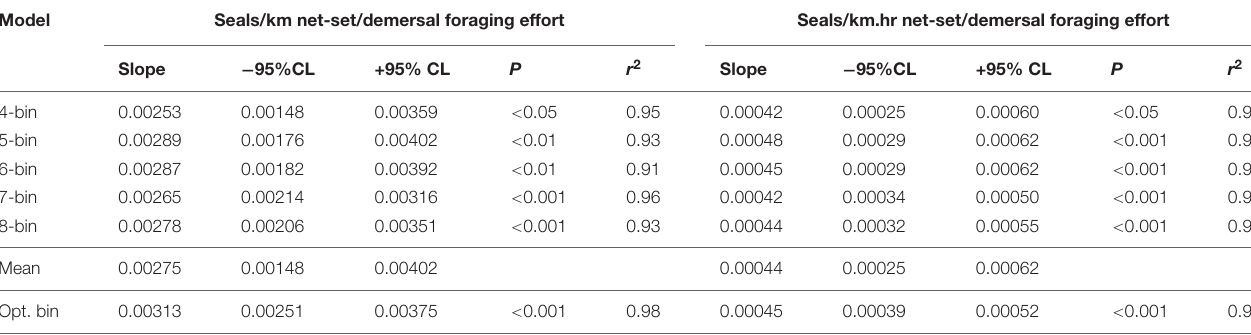
TABLE 3 | Statistical and model coefficient outputs for alternate bycatch estimation models based on the number of data bins and their expression in terms of fishing effort (km and km.hrs). Model Seals/km net-set/demersal foraging